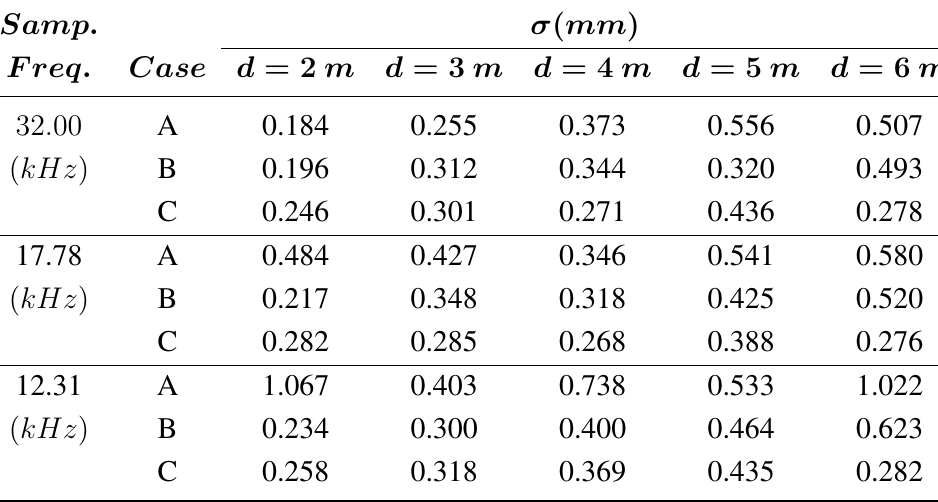
Table 3. Standard deviation ( σ ) of the measurements made at different distances using the A, B and C approaches for the sampling frequencies of 32.00 kHz, 17.78 kHz and 12.31 kHz. At least 500 measurements for each distance, sampling frequency and approach are